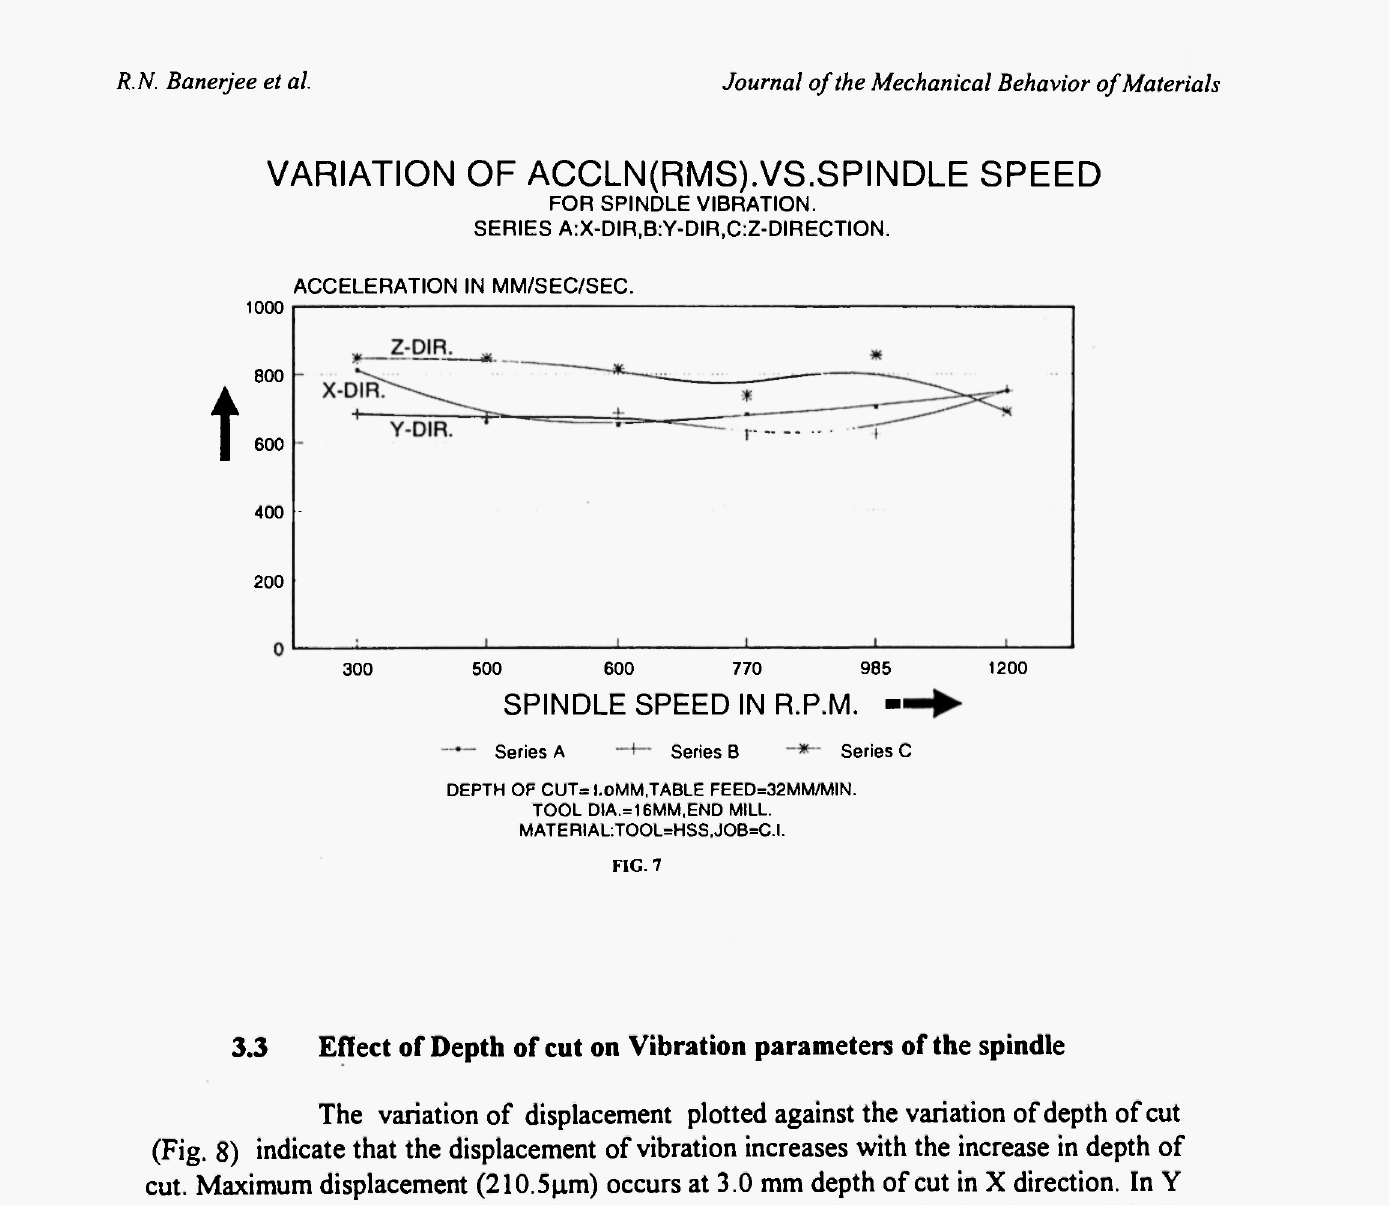
The variation of displacement plotted against the variation of depth of cut (Fig. 8) indicate that the displacement of vibration increases with the increase in depth of cut. Maximum displacement (210.5pm) occurs at 3.0 mm depth of cut in X direction. In Y direction, maximum displacement 201.3 μηι occurs at 1.6 mm depth of cut and in Ζ direction the maximum displacement of 179.1 pm occurs at 2.0 mm depth of cut. But the velocity and acceleration of vibration do not change appreciably with the increase of depth of cut (Figs.